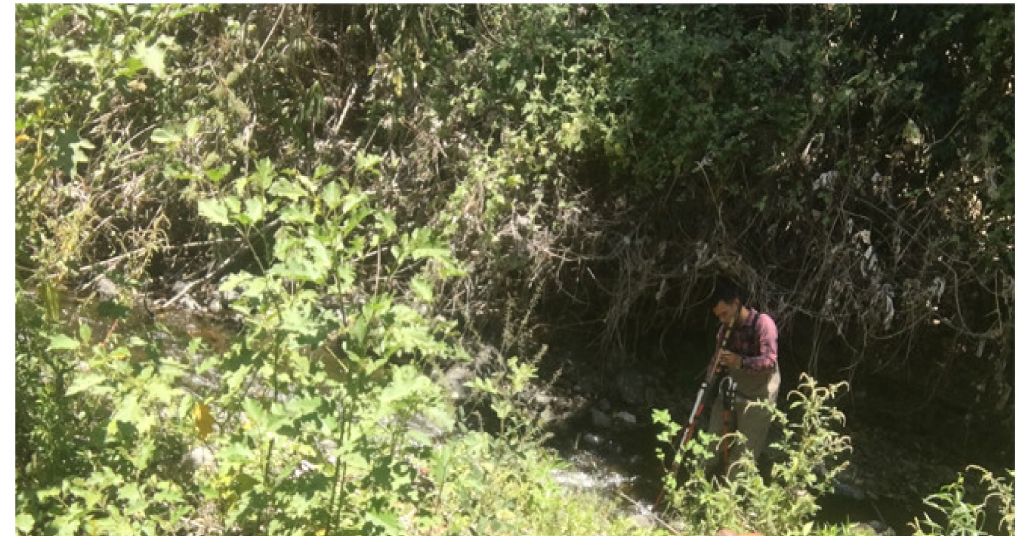
Figure 2. Real scenario for the propagation study. Leaves, twigs, and long branches were constant above 1.5 m over the